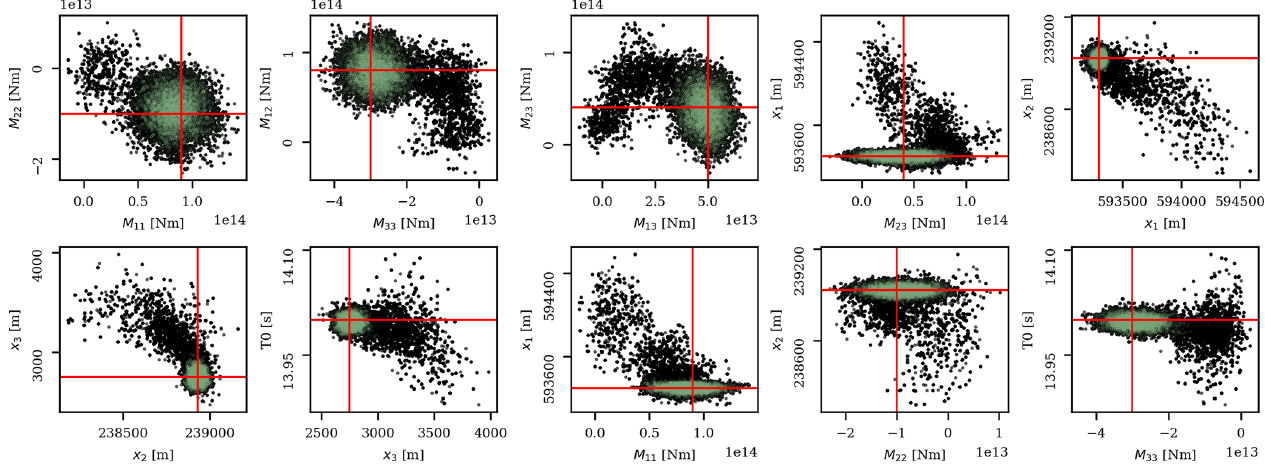
Figure 7. A total of 10 two-dimensional marginal probability densities of the inverted model parameters. Black dots are all the samples given the results from all chains (Fig. 6), whereas the green dots represent the samples from chains that give VR ≥ 85% of the maximum VR, which then represent our final posterior. The red lines are the true values.